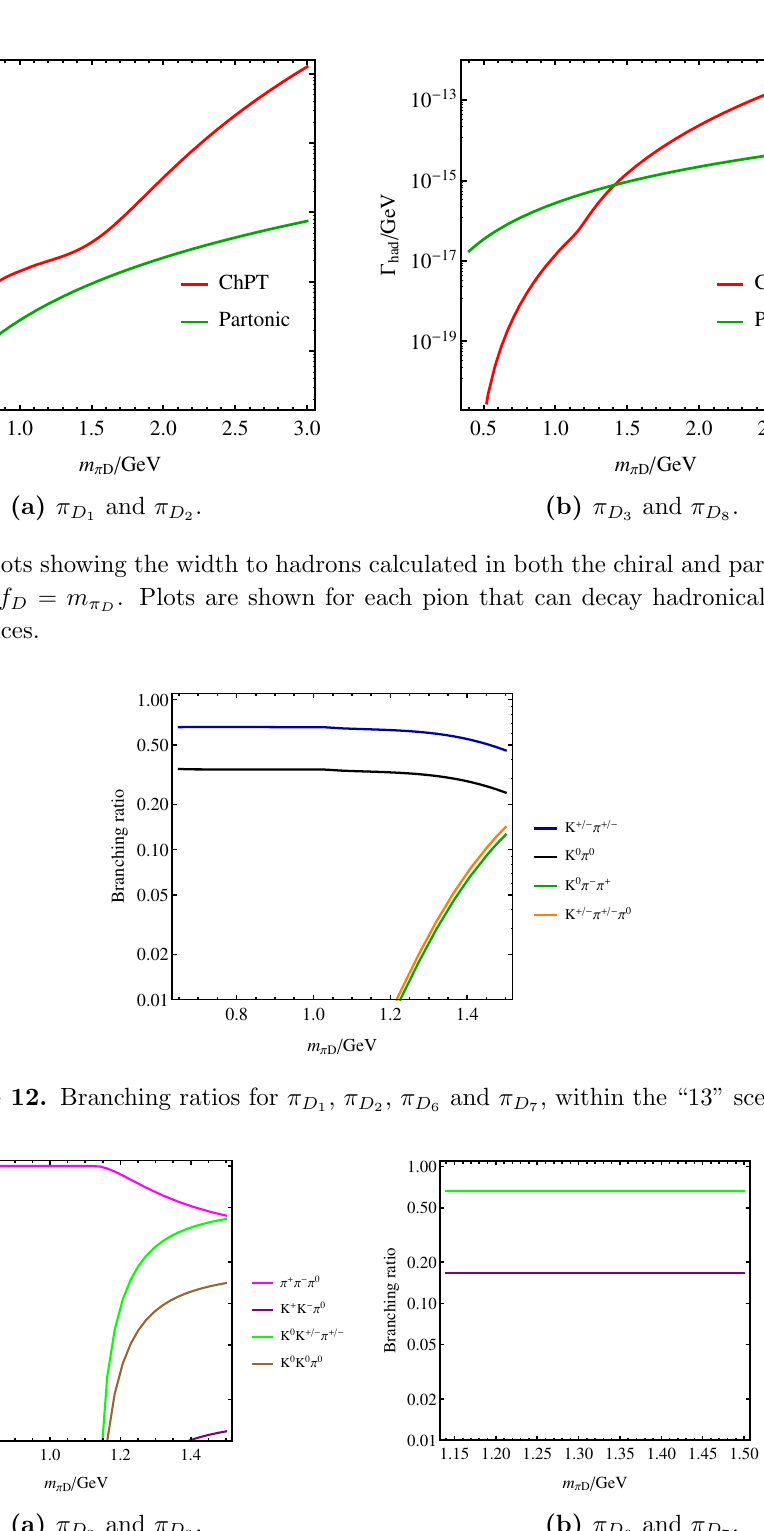
(b) (cid:25) D 6 and (cid:25) D 7 .